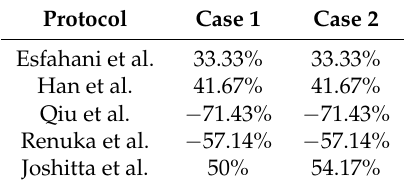
Table 10. The differences in percentages of communication-cost for each scheme against